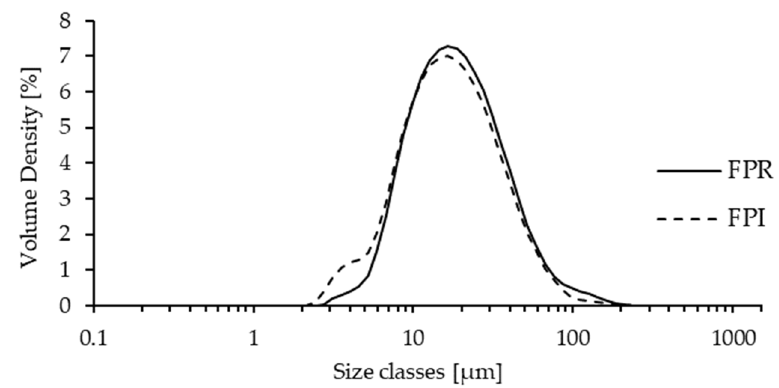
Figure 3. Volume weighted particle size distribution for FPR and FPI after overnight hydration at 4 °C, showing volume density (%) as a function of size class (µm). Table 2. Particle size parameters and surface hydrophobicity for FPR and FPI.